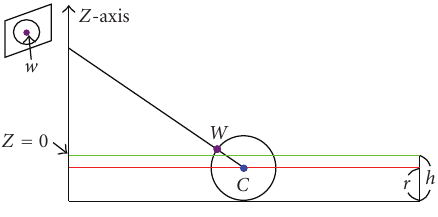
Figure 5: Estimation of a ball position.